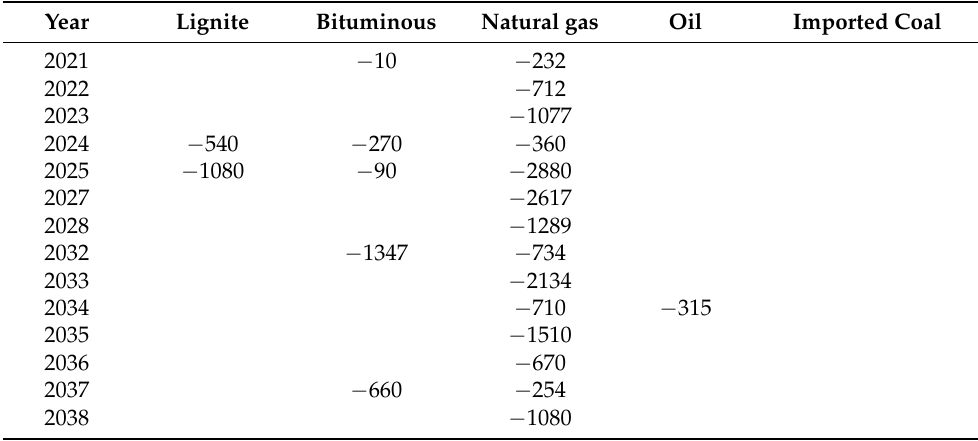
Table A7. Retired conventional fuel unit